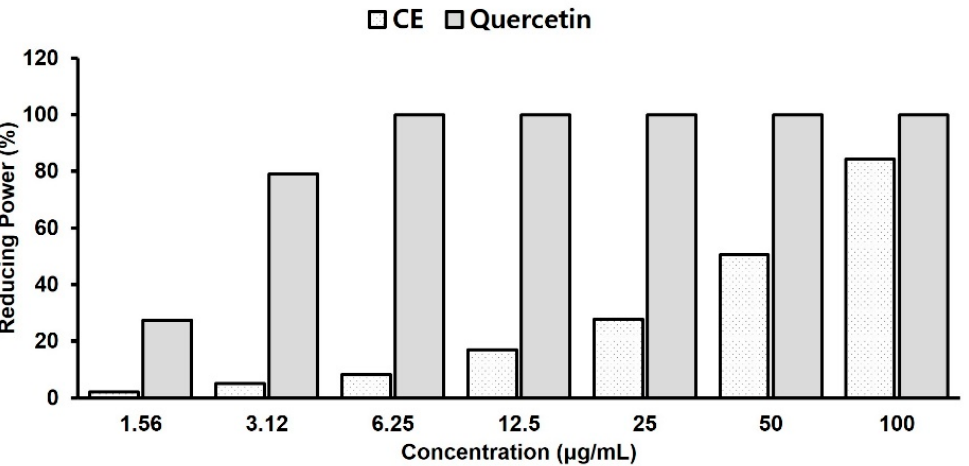
Figure 3. Total antioxidant activity measured by ferric reducing antioxidant power (FRAP) assay for the carotenoid extract (CE). Quercetin is used as a reference compound (concentration range; 1.6–100 µ g/mL). The data are presented as mean ± standard deviation.